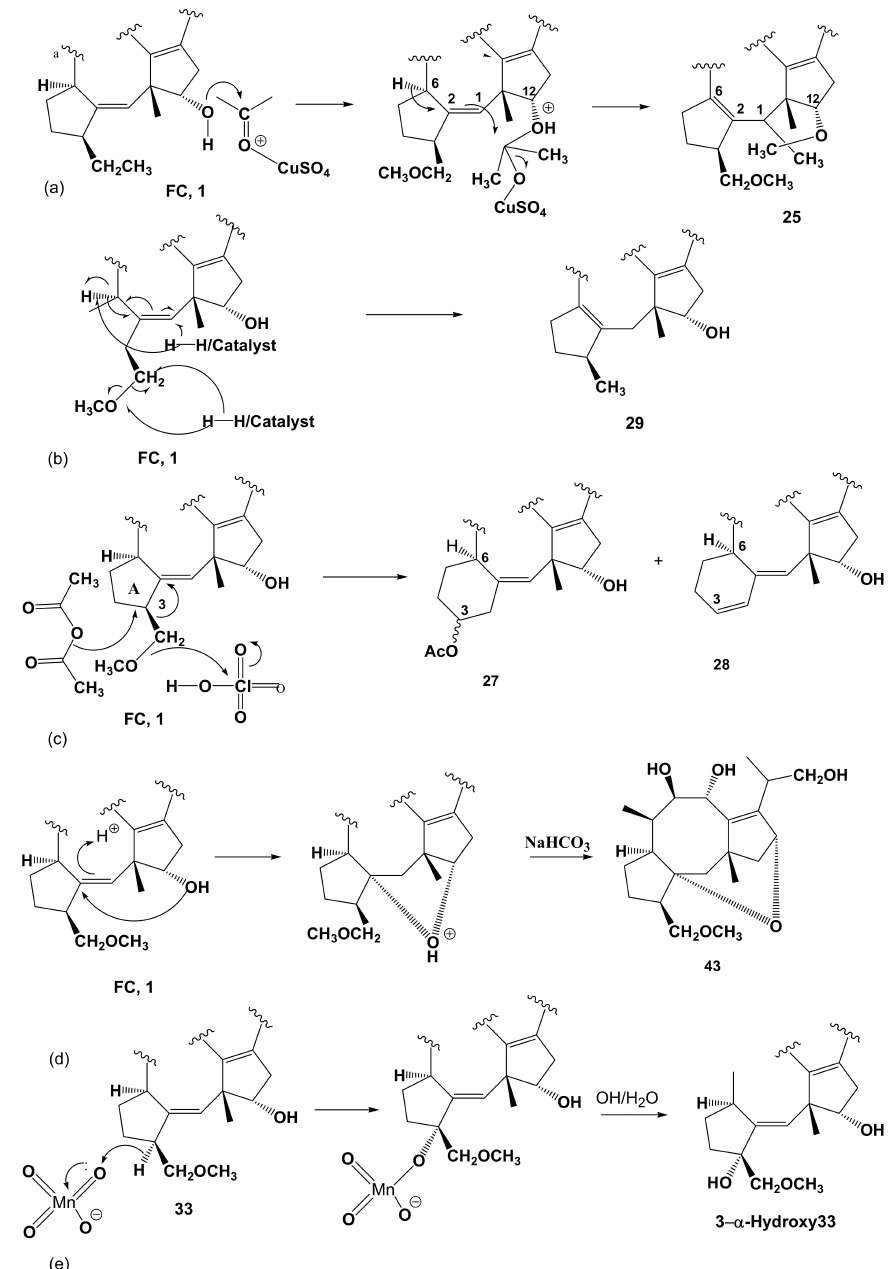
Figure 8. Unusual products obtained from FC derivatization. In ( a – e ) the detailed hypothesized mechanisms are